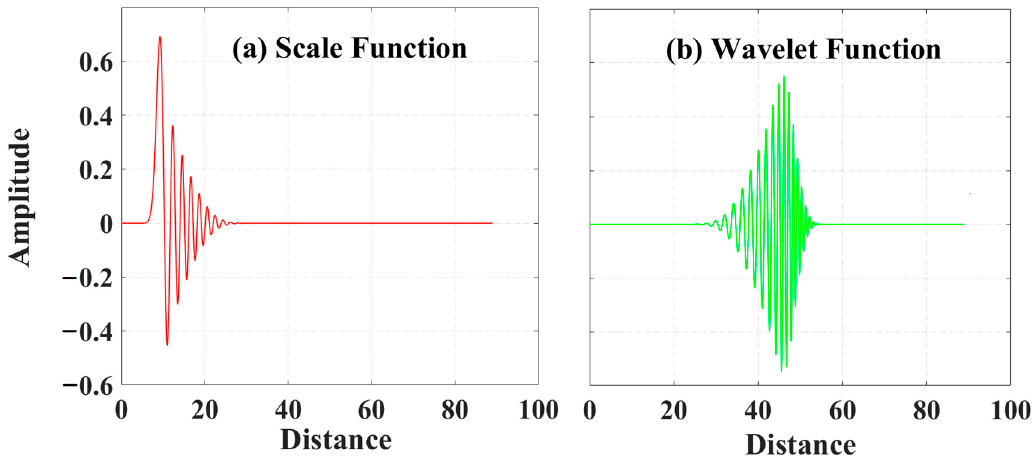
Figure 2. ( a ) Scale function φ ( x ) and ( b ) wavelet function ψ ( x ) of db 45. The horizontal axis is the distance in pixels and the vertical axis is the amplitude (grayscale in this paper), for both images a and b.